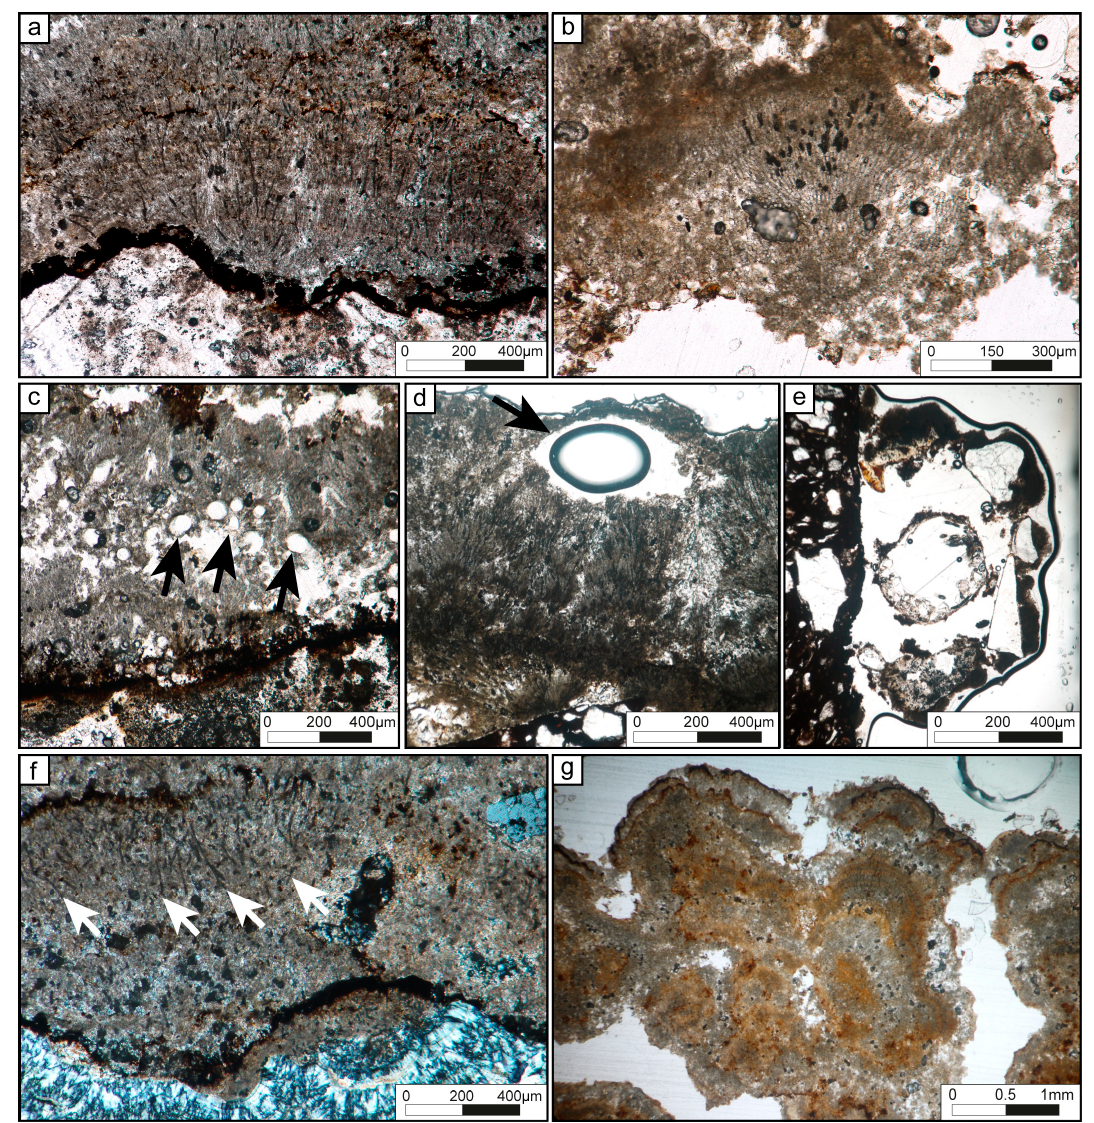
Figure 4. Filamentous-rich microfabrics in thin section view. ( a ) Dense filamentous lamina covering a siliceous substrate; ( b ) segmented filaments forming fan-shaped structures in dense filamentous lamina; ( c ) circle shapes (black arrows) within a dense filamentous lamina; ( d ) cross-section of a larval housing (black arrow) near the surface of a dense filamentous lamina; ( e ) cross-section of Trichoptera pupal cases on the edges of substrate; ( f ) wavy loose filamentous laminae consisting of isolated filaments (white arrows); ( g ) loose filamentous laminae composed of concentric structures and isolated filaments.